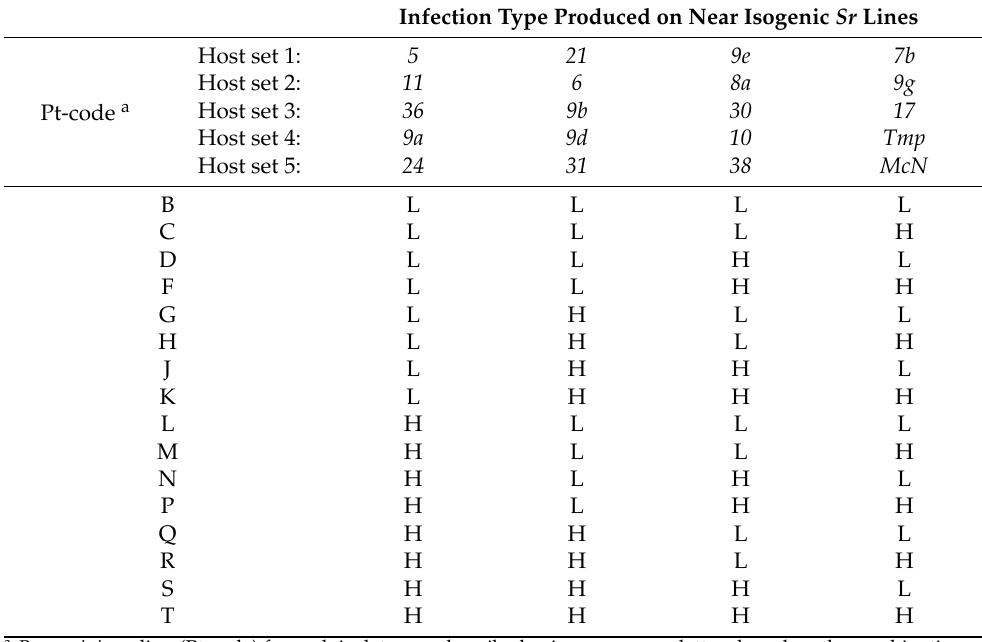
Table 3. Puccinia graminis Pt-code for five sets of the 20 differential hosts. Infection Type Produced on Near Isogenic Sr Lines